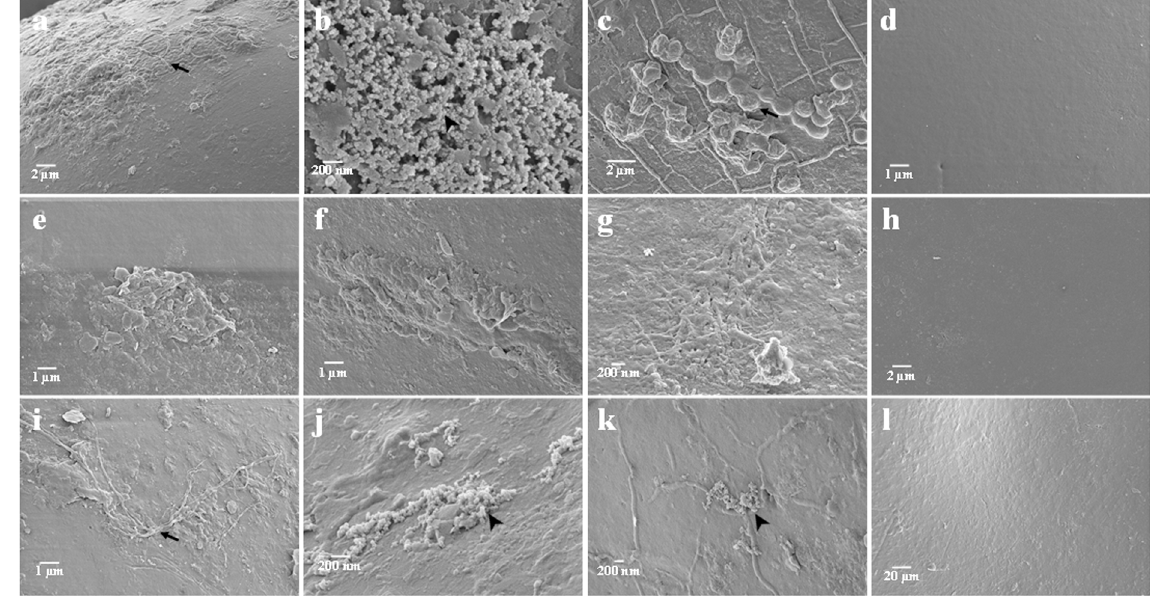
Fig 1. Spore after surface sterilization with disinfection solution at different duration. a, b, c, d — Type 1 spore after surface sterilization at 0, 10, 20 and 30 min. e, f, g, h — Type 2 spore after surface sterilization at 0, 10, 20 and 30 min. i, j, k, l — Type 3 spore after surface sterilization at 0, 10, 20 and 30 min. Arrow marks indicate bacterial cells of various shapes adhering to the spore wall; filamentous bacterial cells (a, i), coccus-shaped bacterial cells (c). Arrowhead indicates the formation of mucilaginous product replacing outer hyaline layer (b, j,